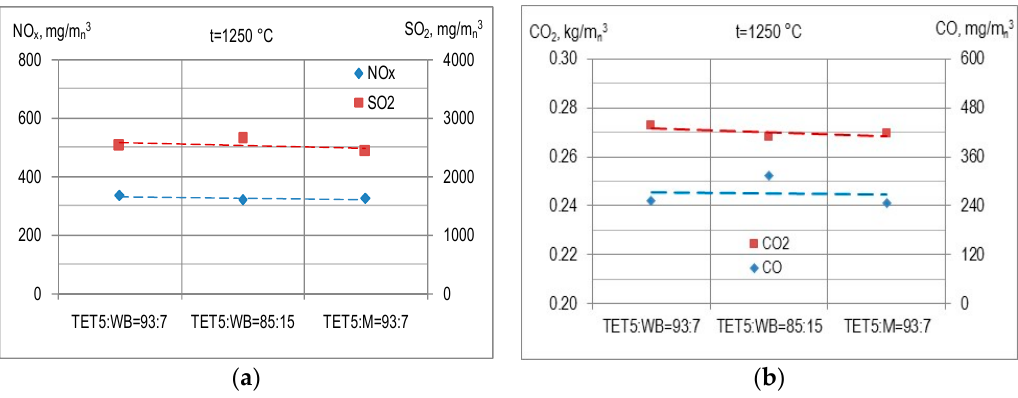
Figure 4. Emissions for different biomass co-firing with coal TET5, ( a ) NO x and SO 2 emissions ( b ) CO and CO 2 emissions.